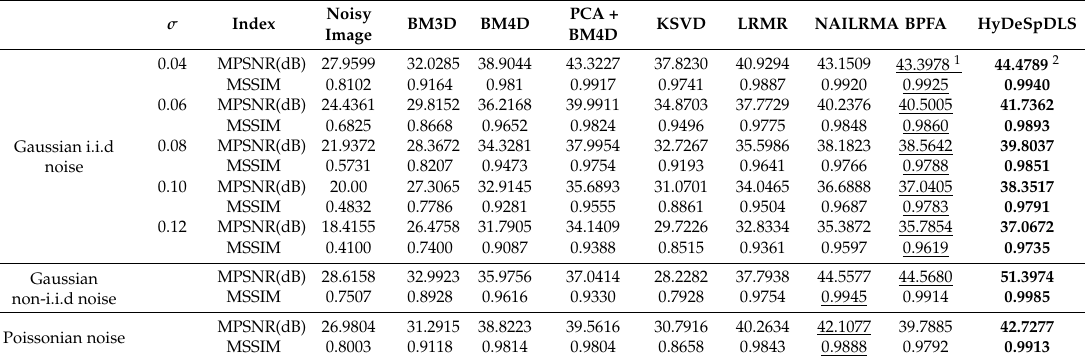
Table 1. Quantitative indexes of different denoising algorithms applied to the Washington DC Mall image.